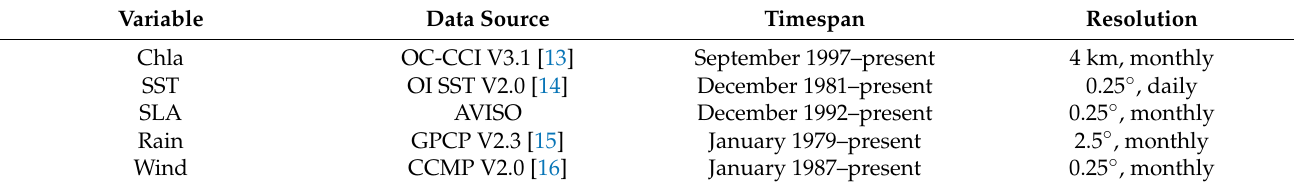
Table 1. Sources, timespans, and resolutions of remote sensing